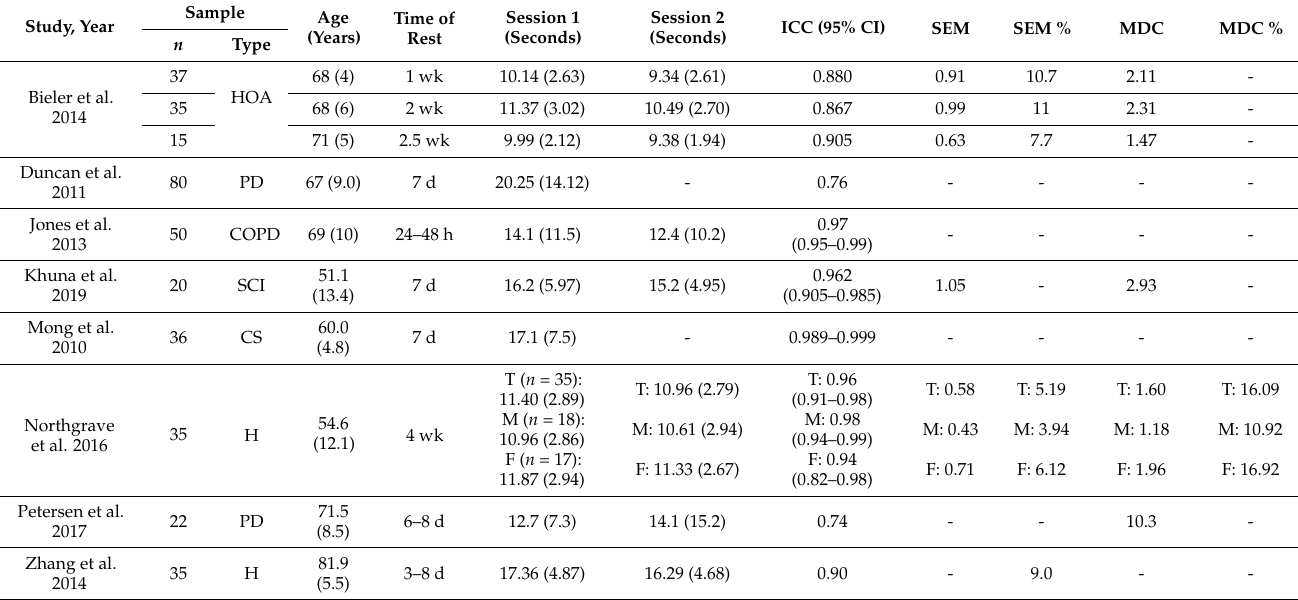
Table 1. Characteristics of the included studies.